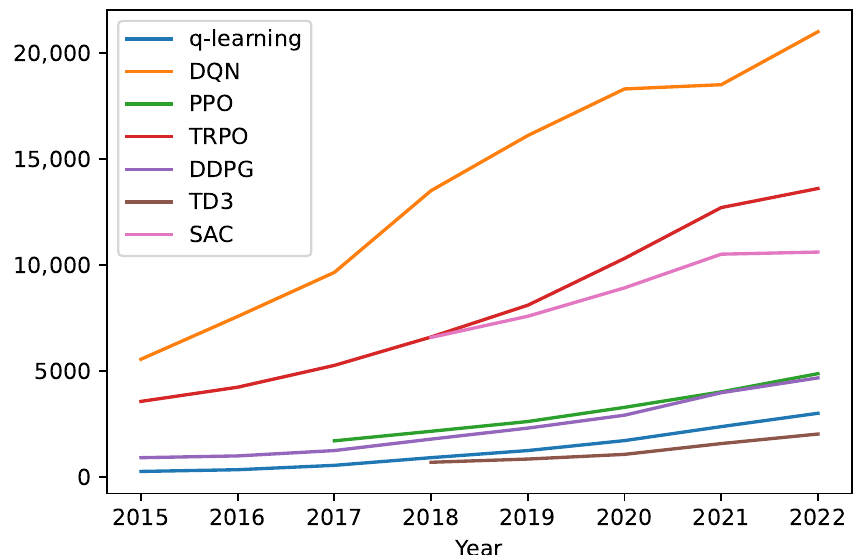
Figure 10. The trend of published papers using different RL algorithms in robotic manipulation.